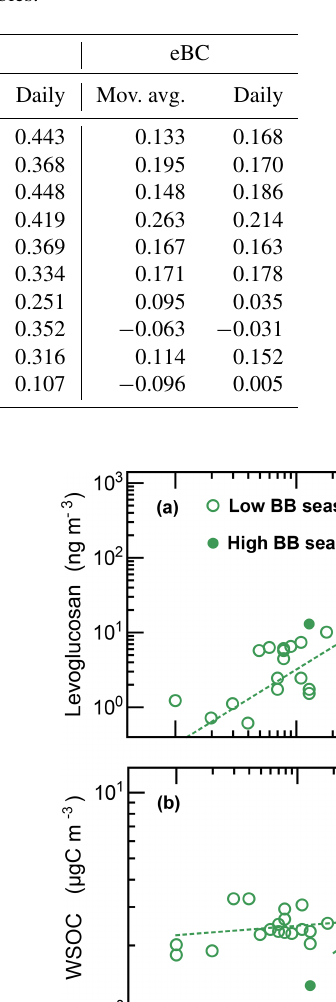
Table 2. Statistical association expressed through the Spearman correlation between the different fire counting methods and eBC and BrC measured at the Monserrate site. “Mov. avg.” is the Spearman correlation between smoothed time series with a 7d moving average, and “Daily” represents the Spearman correlations between daily mean variables.